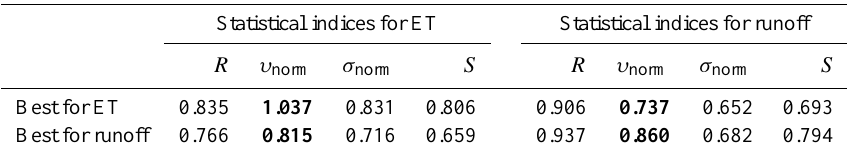
Table 3. Statistical indices when the model returned with the best skill score for ET (upper row) and runoff (lower row). The bold numbers indicate the indices showing the largest differences between ET and runoff simulations. Statistical indices for ET Statistical indices for runoff R υ